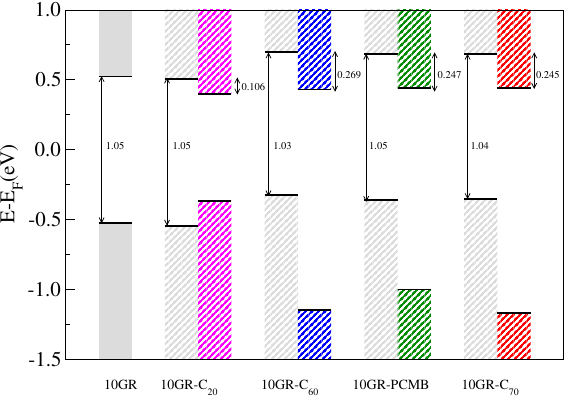
Figure 9. Schematic representation of the band gap of a 10GR nanoribbon and the band alignment of the different 10GR–fullerene